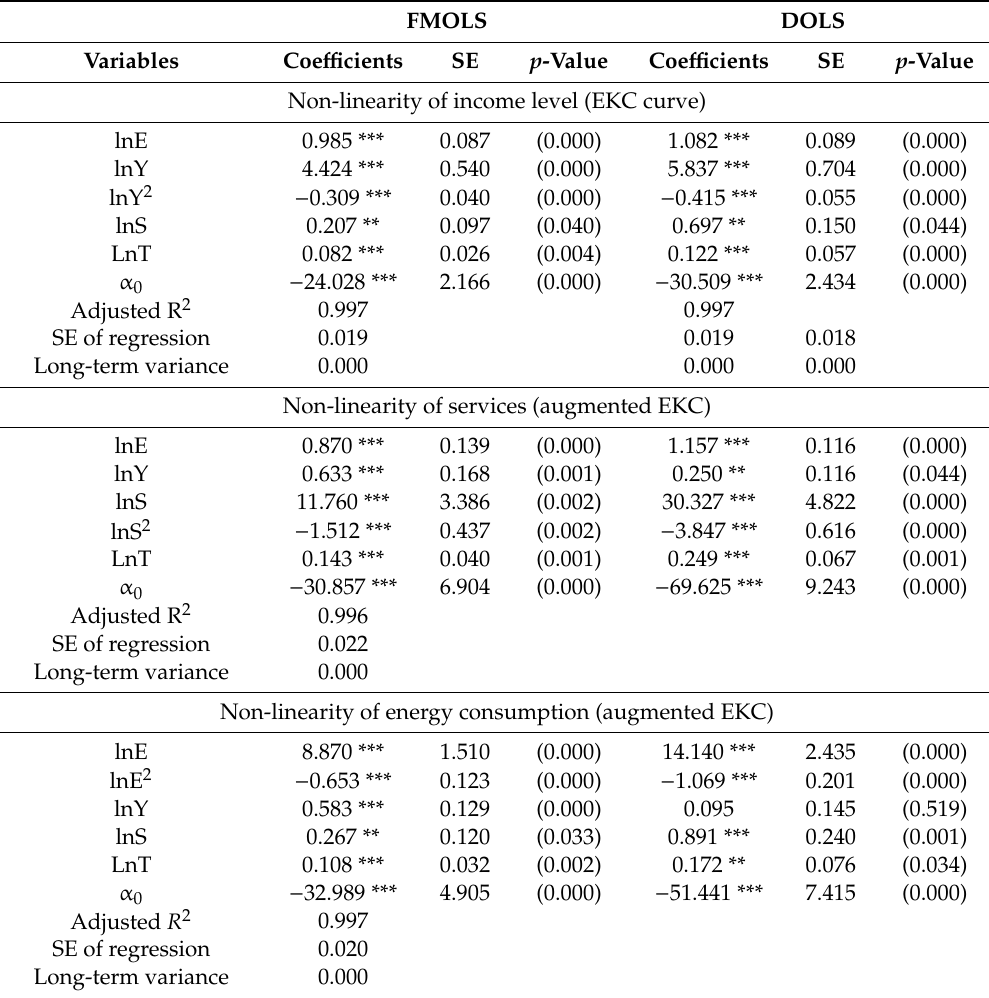
Table 8. Estimating long-run elasticities using fully modified ordinary least squares (FMOLS) and dynamic ordinary least squares